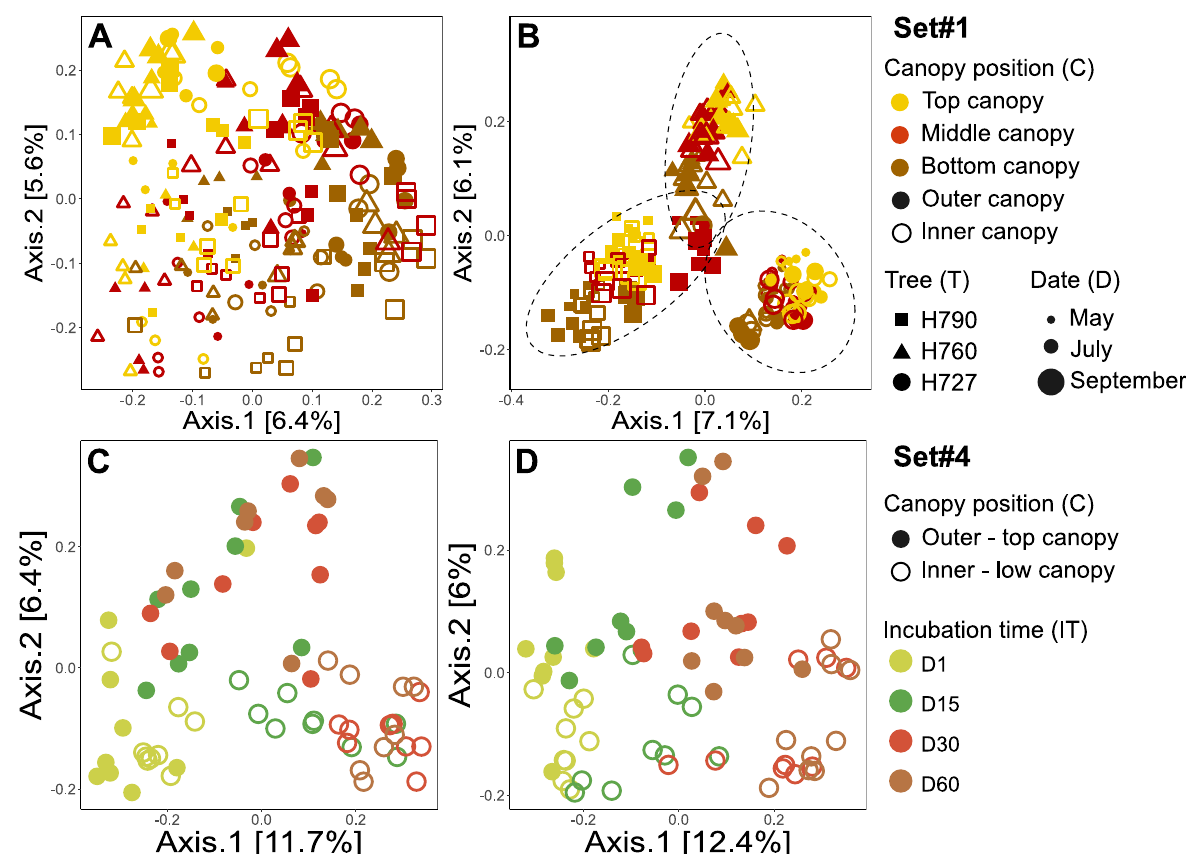
Fig. 2 Variation in leaf microbial community composition in European beech ( Fagus sylvatica ), depending on leaf position within the canopy, tree and date ( A and B ) and leaf decomposition stage ( C and D ). Dissimilarities among samples were estimated using a binary version of Jaccard distance and represented with PCoA plots. Plots A and C represent bacterial community dissimilarities. Plots B and D represent fungal community dissimilarities. In plots A and B, colors indicate within-canopy vertical and horizontal positions, shapes indicate the tree sampled and size indicate the date of sampling. Confidence ellipses (95%) are drawn around tree (T) for fungal communities. In plots C and D, colors indicate incubation times and shapes indicate leaf initial position within the canopy. All factors had significant effects on microbial composition (Tables 3 and 5 in